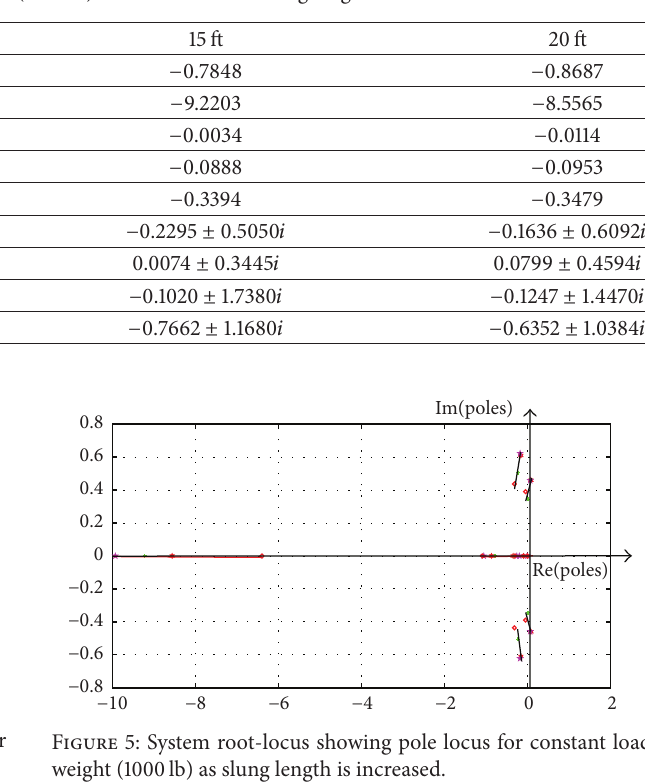
Table 2: System poles for a fixed load (1000lb) but with different slung lengths.